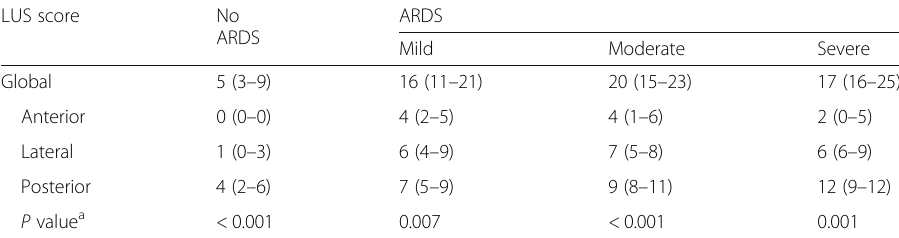
Table 4 Detailed LUS scores LUS